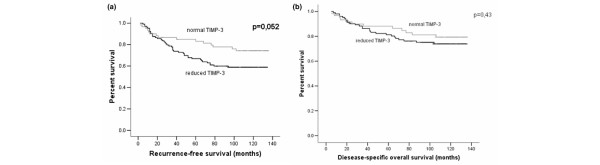
The prognostic significance of TIMP-3 protein expression in the entire patient population. The graphs show the effect of tissue inhibitor of metalloproteinases (TIMP)-3 expression on patient recurrence-free (a) and disease-specific overall (b) survival (log-rank test).